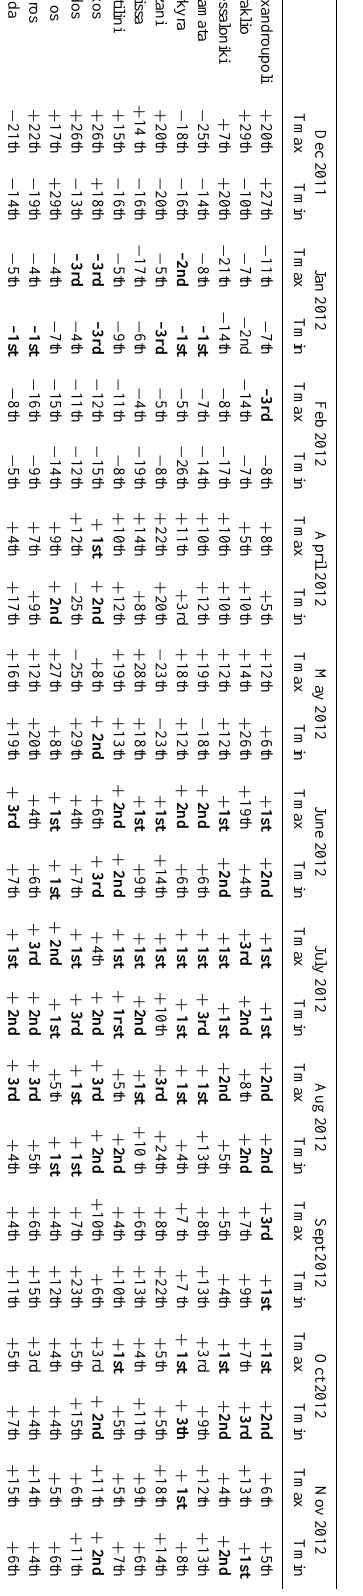
Fig. 4. As Fig. 1 but for June